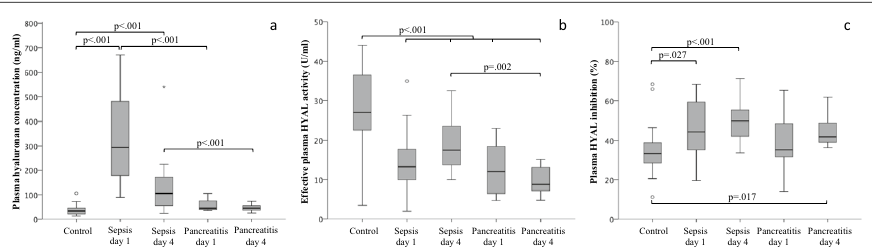
Fig. 3 a – c Clinical experiments. a Plasma hyaluronan concentration, b effective plasma HYAL activity and c plasma HYAL inhibition for control, sepsis day 1 and day 4, pancreatitis day 1 and day 4. p -value from Mann– Whitney U